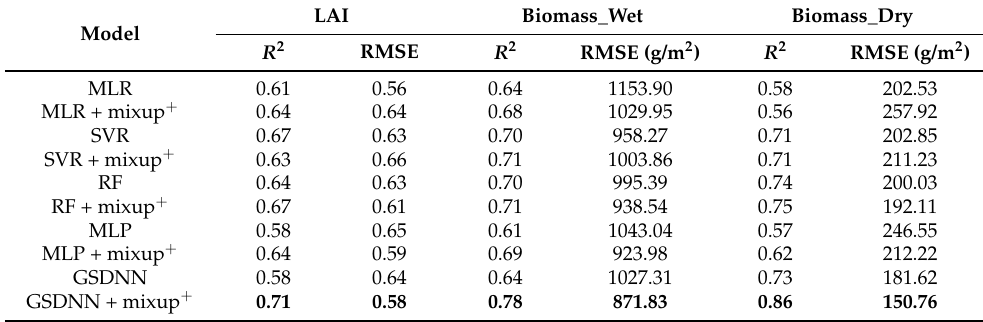
Table 4. Comparison of multiple machine learning methods before and after the use of mixup +